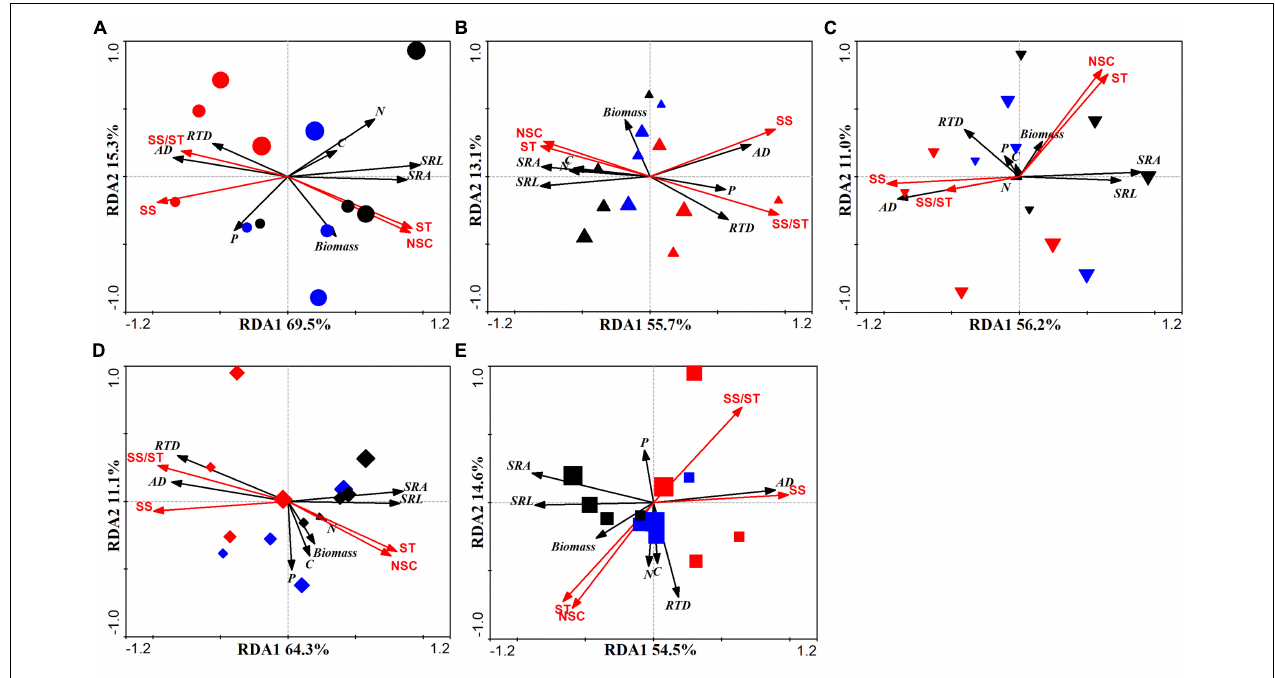
FIGURE 5 | Redundancy analysis of fine root morphological and chemical traits in different drought intensity and soil substrates. (A) 1st-order root; (B) 2nd-order root; (C) 3rd-order root; (D) 4th-order root; and (E) 5th-order root. Red symbols, humus soil; blue symbols, loam soil; black symbols, sandy-loam soil. SRL: specific root length; SRA: specific root surface area; AD: average diameter; RTD: root tissue density; SS: soluble sugar; ST: starch; C: root carbon; N: root nitrogen; P: root phosphorus. The greater symbols indicate the stronger drought